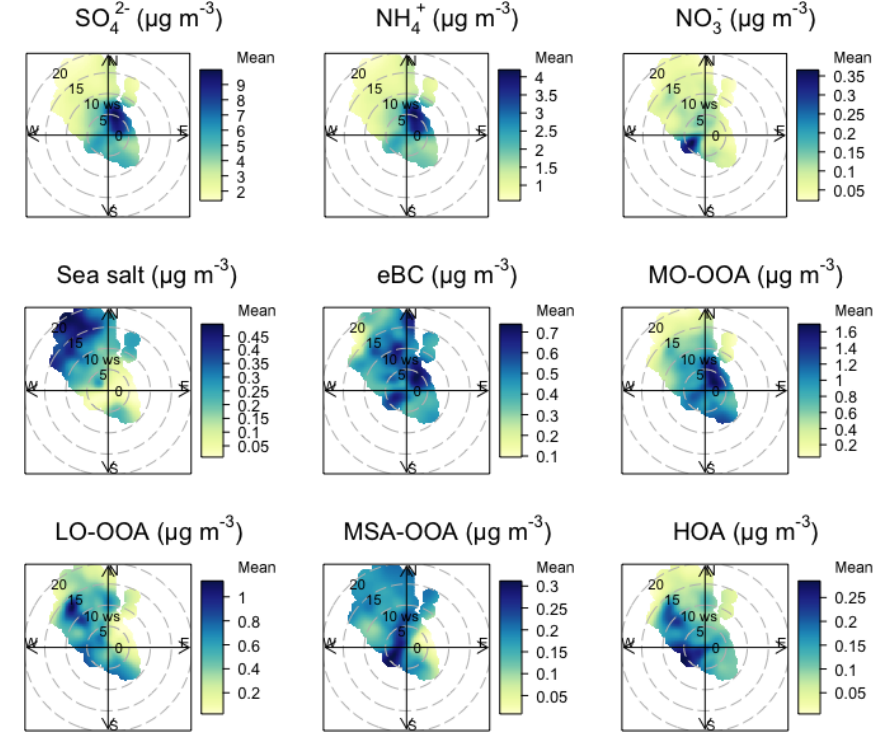
Figure 10. Bivariate polar plots of mean concentrations of PM 1 species and f 44 at Lampedusa. The angle represents the arrival wind direction, the radius represents the wind speed, and the colours represent the mean concentrations for the respective wind directions and winds.